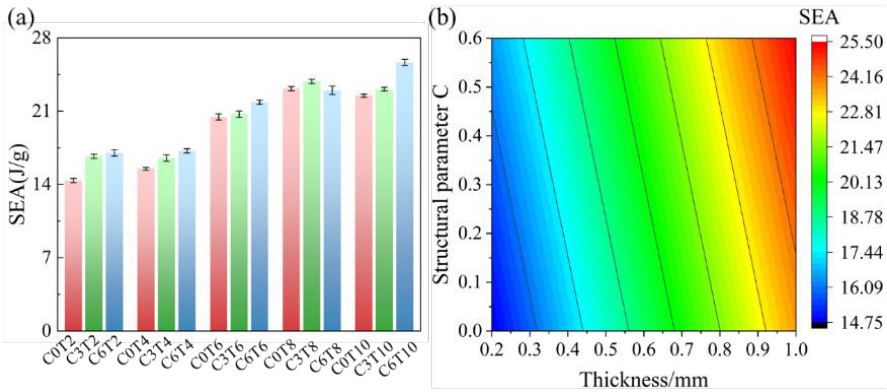
Figure 12. ( a ) Specific energy absorption of as-built primitive TPMS. ( b ) The predicted value of spe- cific energy absorption under different structural